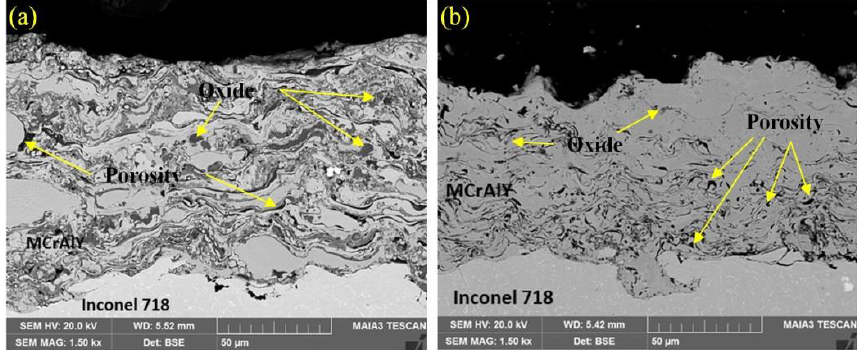
Figure 2. Cross-sectional SEM image of as-sprayed CoNiCrAlY coatings: ( a ) D-gun technique; ( b ) SSPS technique.